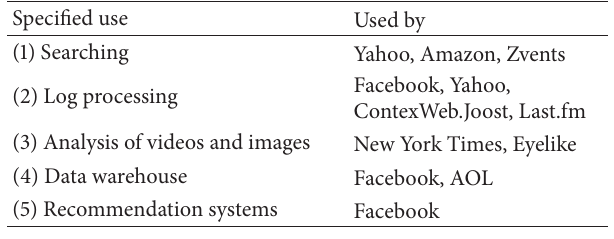
Table 3: Hadoop usage.